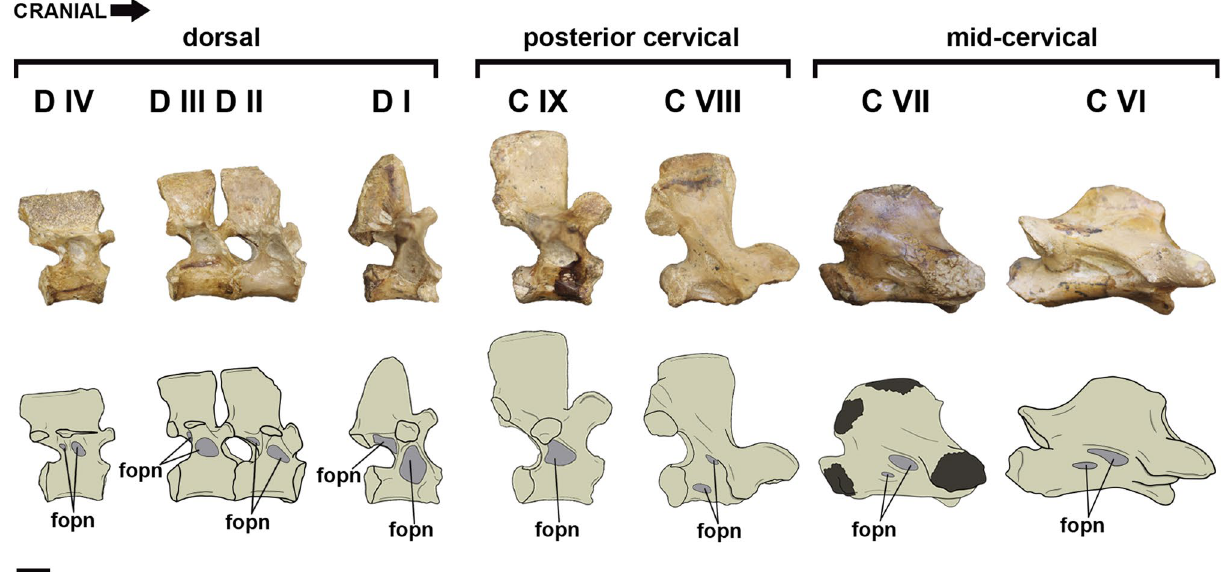
Figure 2. Scanned vertebral sequence belonging to SNSB/BSPG 1991 I 27. Abbreviations: fopn, pneumatic foramen. Scale bar: 10